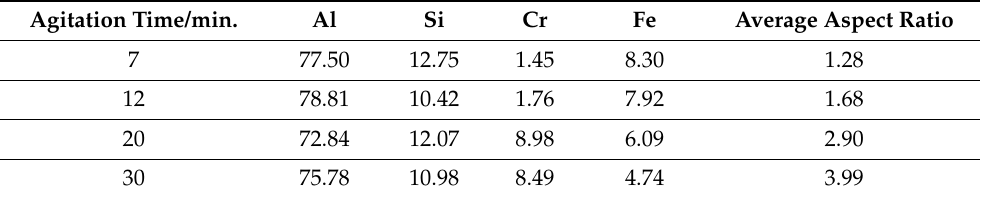
Table 2. Average composition (atm.%) and average aspect ratio of particles of the first type. Agitation Time/min.